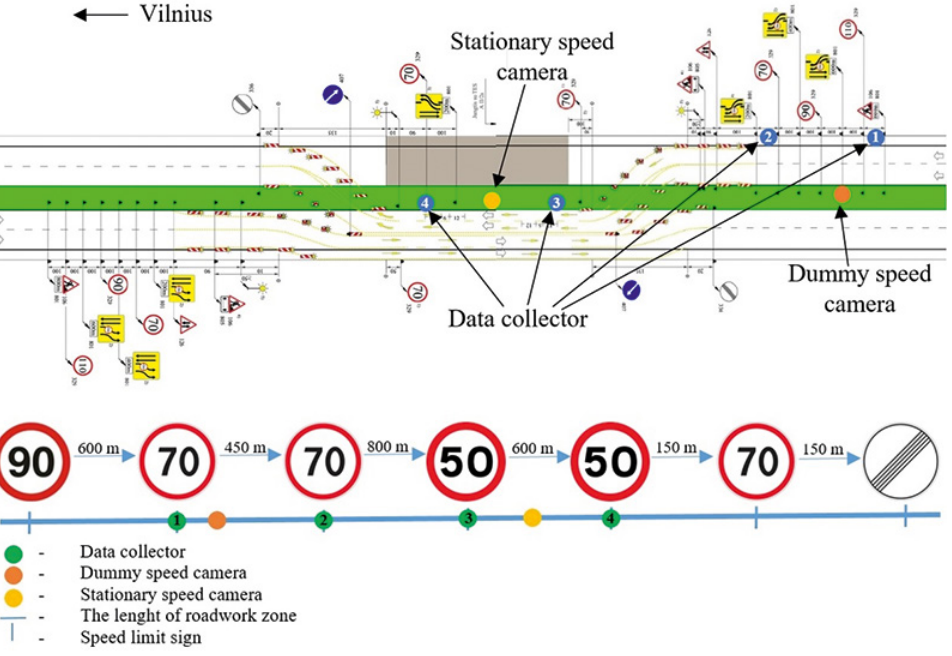
Figure 2. The scheme of speed measuring in a roadwork zone